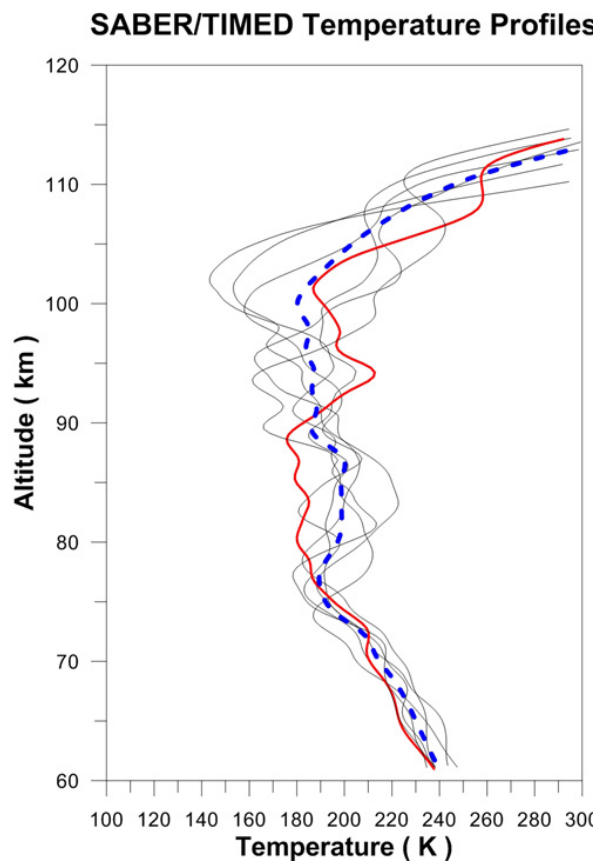
Fig. 3. Temperature profiles of SABER/TIMED overpasses for 12 ◦ –22 ◦ N latitude and 69 ◦ –79 ◦ E longitude range during February–March